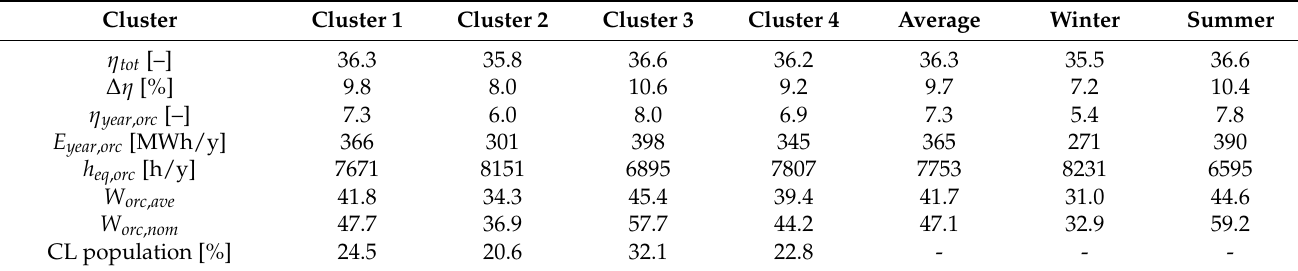
Table 5. Modified layout performance for the four possible ORC configurations. Reference case fuel efficiency equal to 33%. Cluster Cluster